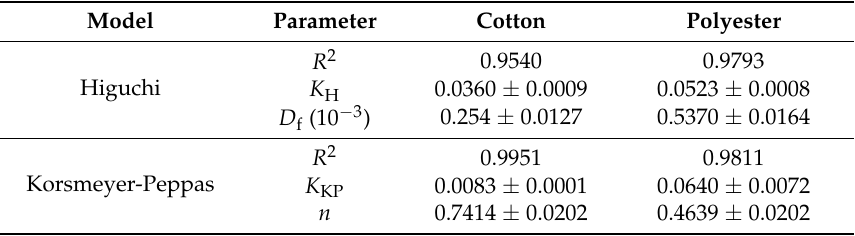
Table 5. Model parameters for controlled release of complexed oil applied to cotton and polyester.